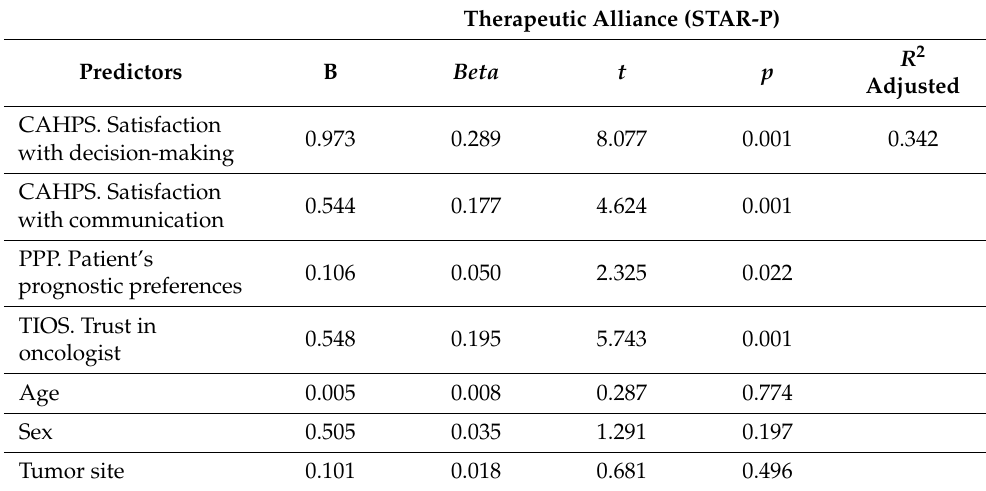
Table 3. Linear regression models for therapeutic alliance predictors ( n =